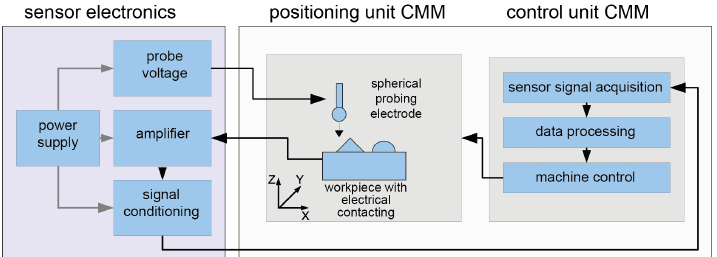
Figure 3. Information flow in the measurement set-up.